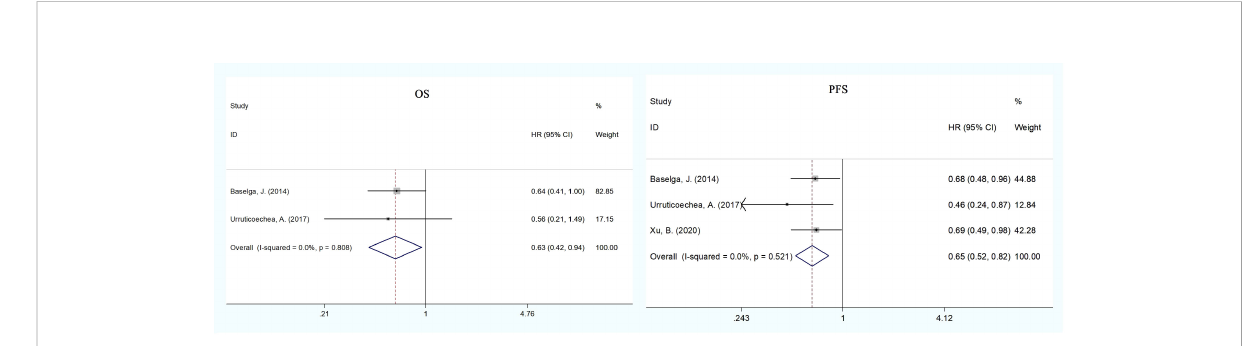
FIGURE 3 Subgroup analysis of OS and PFS between the dual anti-HER2 therapy group (pertuzumab plus trastuzumab) and the monotherapy group in advanced breast cancer in Asian patients. The size of the squares indicates the weight of the study. Error bars represent 95% con fi dence intervals (CIs). The diamond indicates the summary odds ratio. No evidence of publication bias was detected for OS (Begg ’ s test: p = 1.000) and PFS (Egger ’ s test: p = 0.752, Begg ’ s test: p =